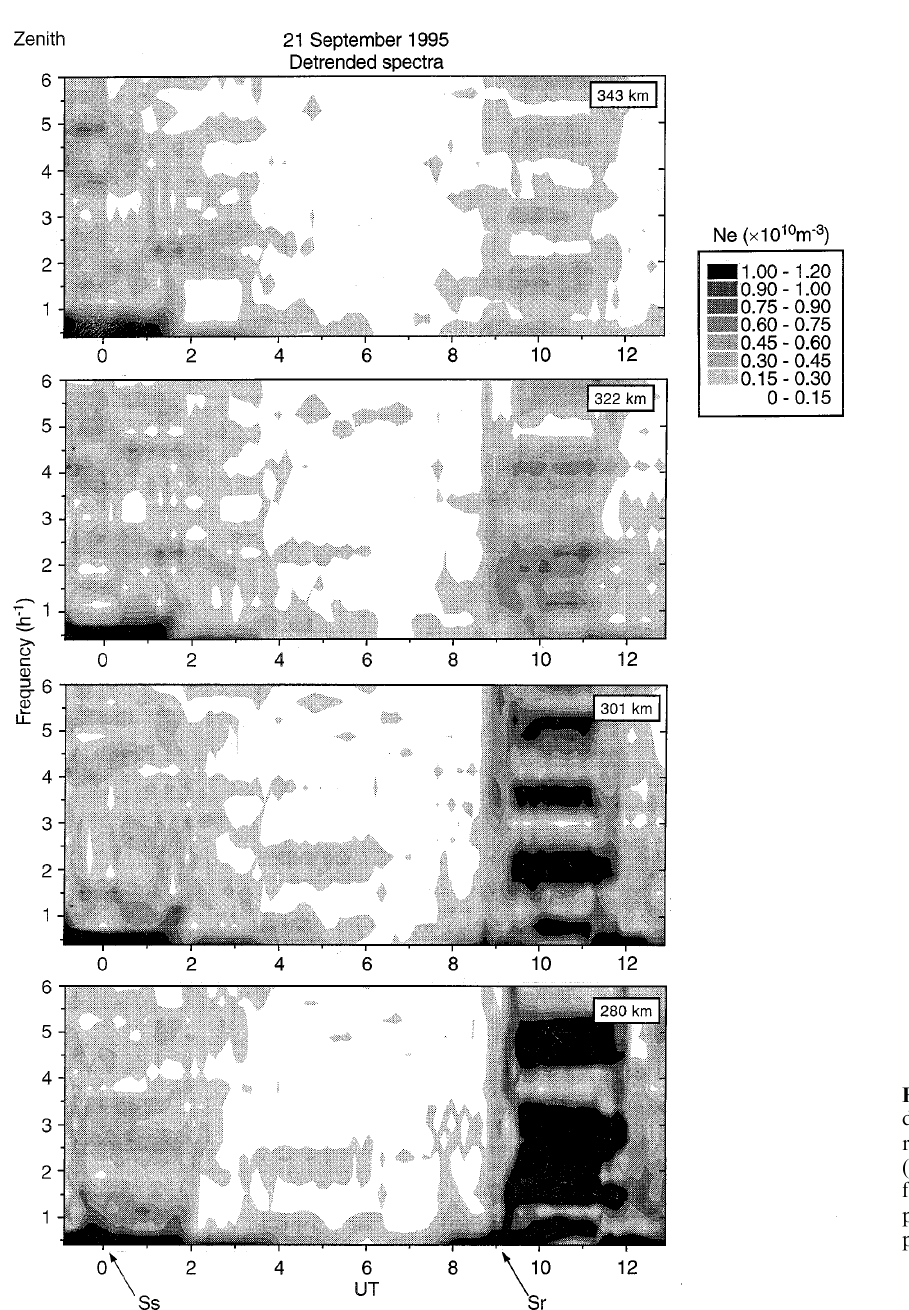
Fig. 3. Spectral power of the detrended density data at four F -region altitudes reveal strong intensification of wavelike (banded) disturbances in the two hours following sunrise (at (cid:24) 09 UT). The most powerful spectral components corres- pond to temporal periods of 1.5